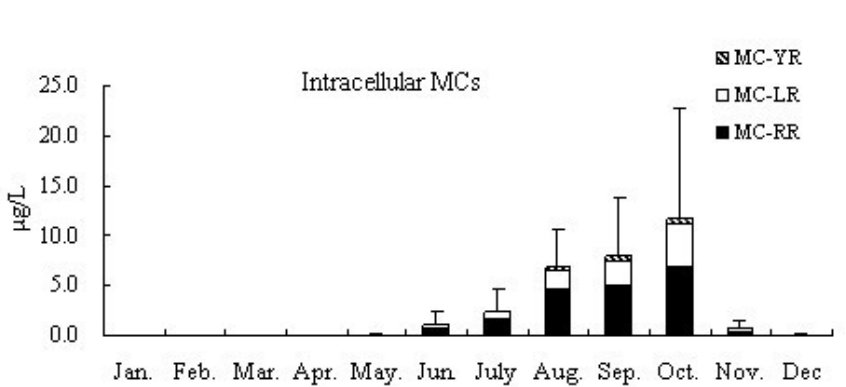
FIGURE 3. Seasonal variations of intra- and extracellular MCs (MC-RR+-LR+-YR) in Gonghu Bay 2008 (means ± standard deviation).